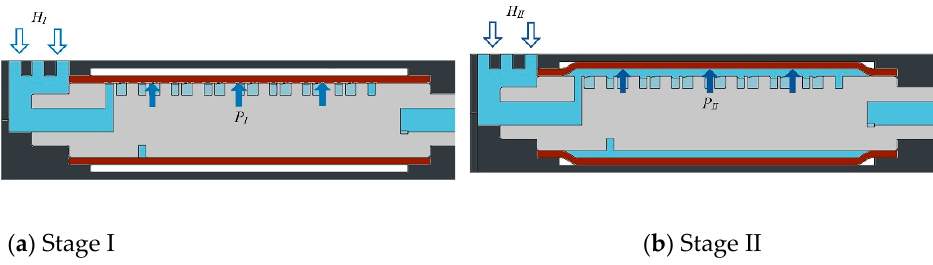
Figure 3. A sectional view of the variable flow emitter in the working stage I (a) and stage II (b). Note: P I and q I are the pressure of the internal flow of the flow channel on the elastomer and the outflow flow rate in the conventional flow supply stage I, respectively. P II and q II are the pressure of the internal water flow of the flow channel on the elastomer and the outflow flow rate in the larger flow supply stage II, respectively.